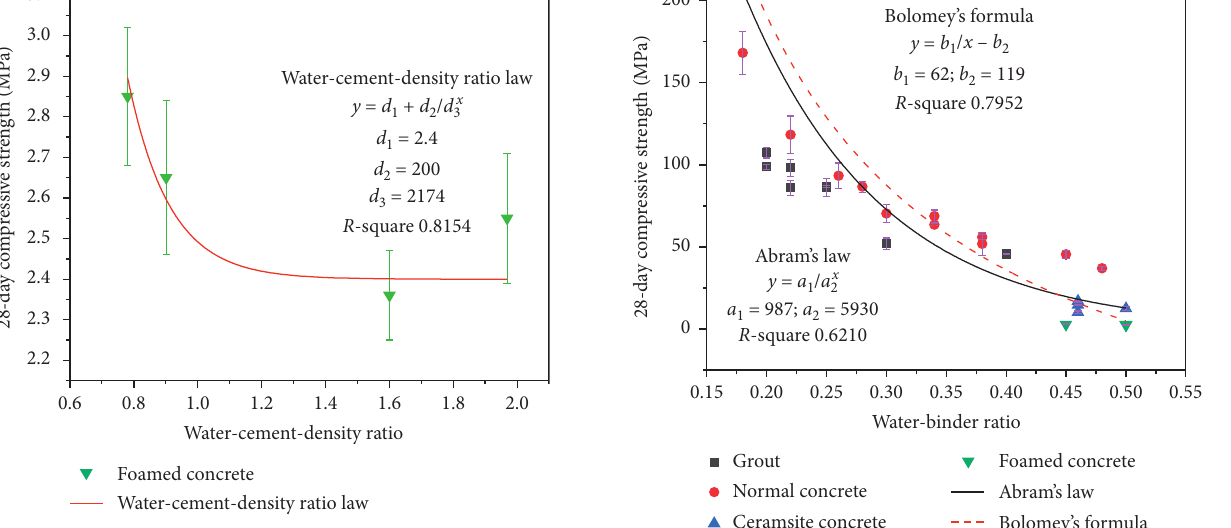
Figure 8: Simulation of water-cement-density ratio law for foamed concrete.